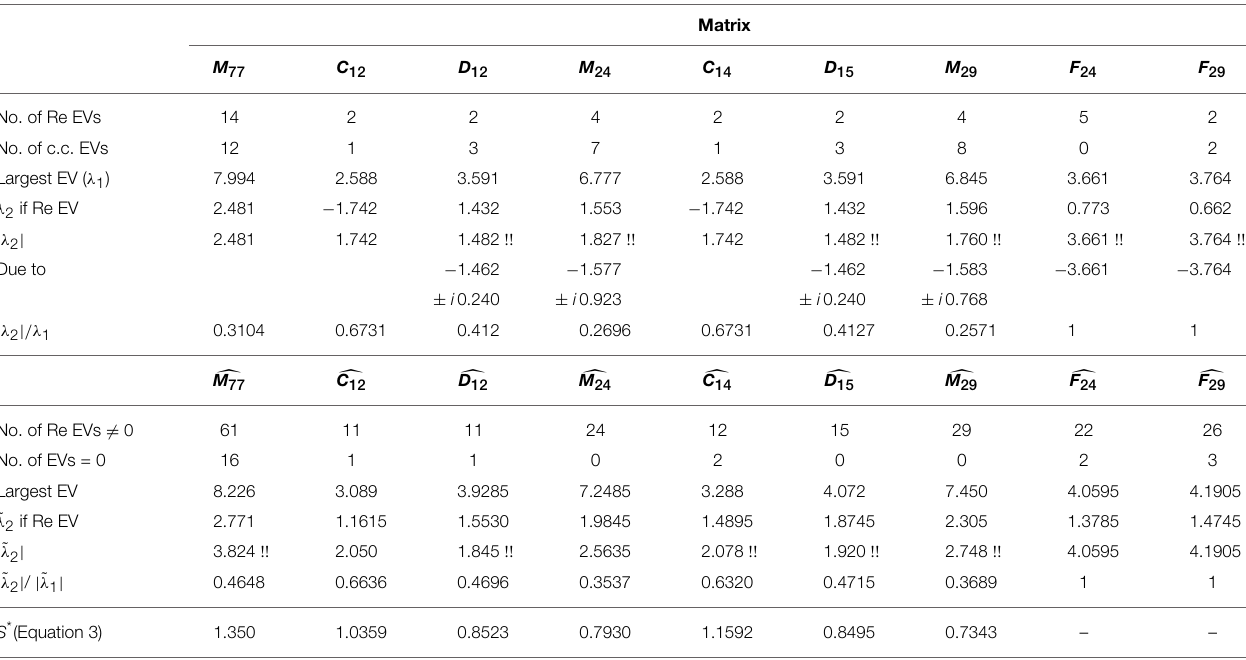
TABLE 2 | Characteristics of the main eigenvalues (EVs) for the various adjacency matrices pertinent to the investigated networks.